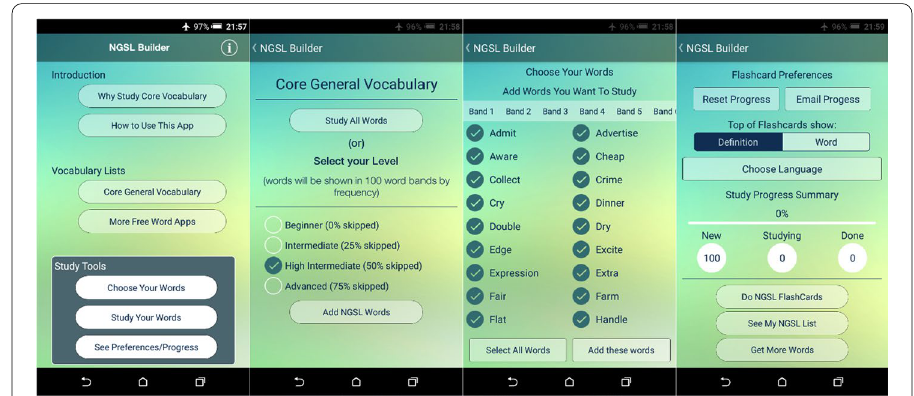
Fig. 1 Screenshots representing set up features in NGSL Builder